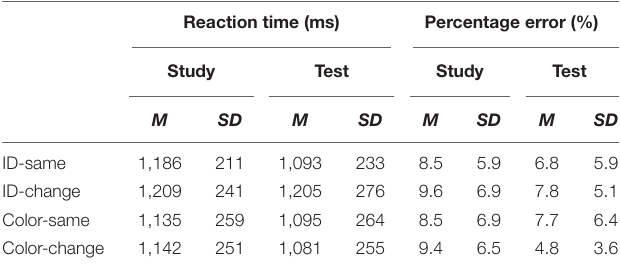
FIGURE 3 | RT differences between the study and test blocks in the math task as a function of feature and condition in Experiment 1. Error bars show ± 1 standard deviation of the